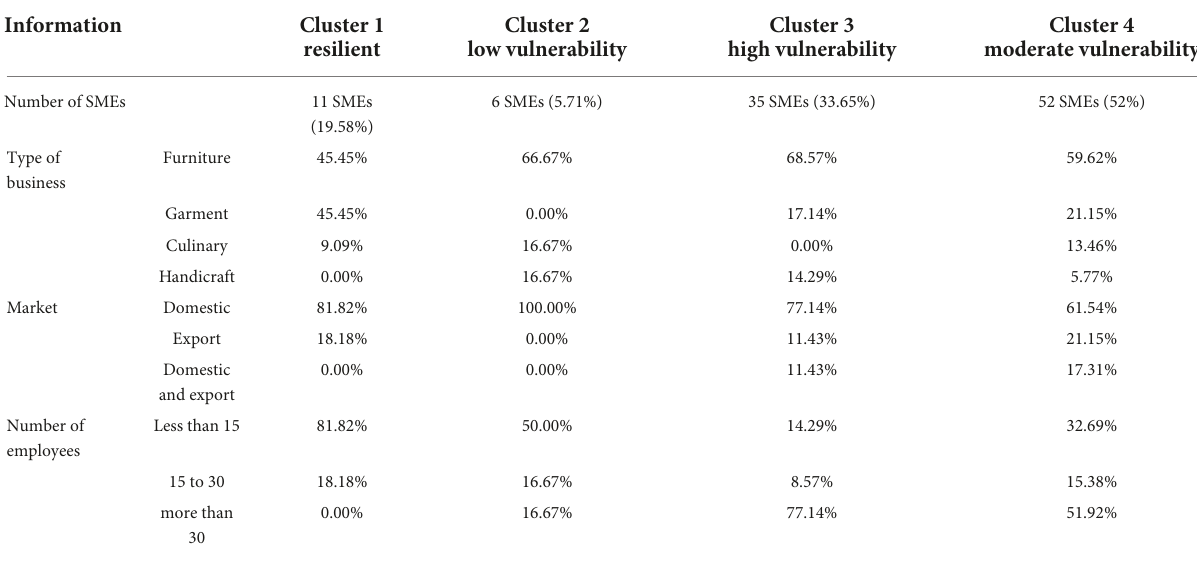
TABLE 3 Characteristics of each